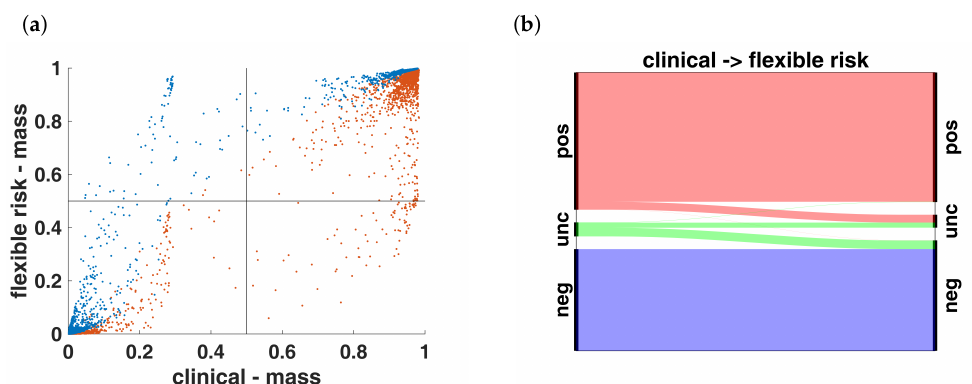
Figure 8. Illustration of the shift towards hormone receptor negative outcome by an improved linkage between hormone receptors (Formula (9)): ( a ) red dots are weights α for receptor positive, blue dots are weights β for receptor negative. ( b ) incorrect favoring of positive hormone receptor status has been revised by using ⊕ 0.5 instead of ⊗